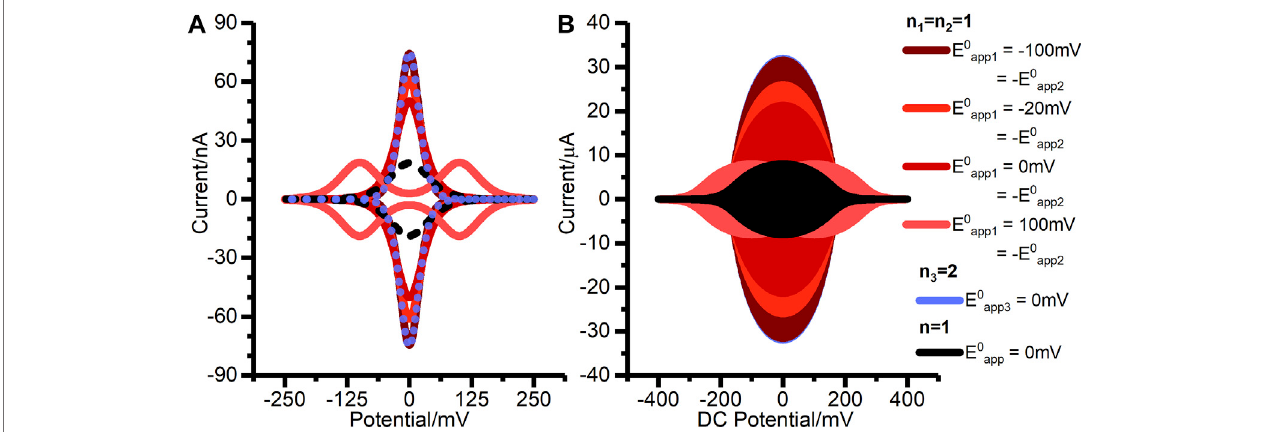
FIGURE8| Simulated (A) DCV,and (B) FTACVoutputsfortwo-stepwiseone-electrontransferprocesses( n 1 (cid:2) n 2 (cid:2) 1)when(solidpinkline) E 0 app 1 > E 0 app 2 (solidlight redline) E 0 app 1 (cid:2) E 0 app 2 ,and(solidorangeanddarkredlines) E 0 app 2 > E 0 app 1 .Thedataisalsocomparedto(dashedblackline)asingle,reversibleoneelectrontransfer( n (cid:2) 1), and (dotted blue line)a single,reversibletwo-electron ( n 3 (cid:2) 2) transfer.Forthe DCVsimulationsin (A) all electron transfer rateconstantswere set to10,000 s − 1 ,whilefor the simulations FTACV in (B) all electron transfer rate constants were set to 100,000 s − 1 . The other parameters used for these simulations were: η (cid:2) 0 . 0 rad s − 1 , ζ (cid:2) 1 . 0, Γ (cid:2) 10 . 0 pmol, S (cid:2) 0 . 01 cm − 2 , v (cid:2) − 20 mVs − 1 , T (cid:2) 298 . 15 k, all α values were set to 0.5, and uncompensated resistance and capacitance were set to zero. 0 For (A) E start (cid:2) 250 mV, E reverse (cid:2) − 250 mV, f (cid:2) 0 . 0 Hz, and Δ E (cid:2) 0 mV while for (B) E start (cid:2) 400 mV, E reverse (cid:2) − 400 mV, f (cid:2) 9 . 0 Hz, and Δ E (cid:2) 150 mV. The n (cid:2) 1 simulations were completed using the two-stepwise one-electron transfer model and setting the second rate constant ( k 0 app2 ) to